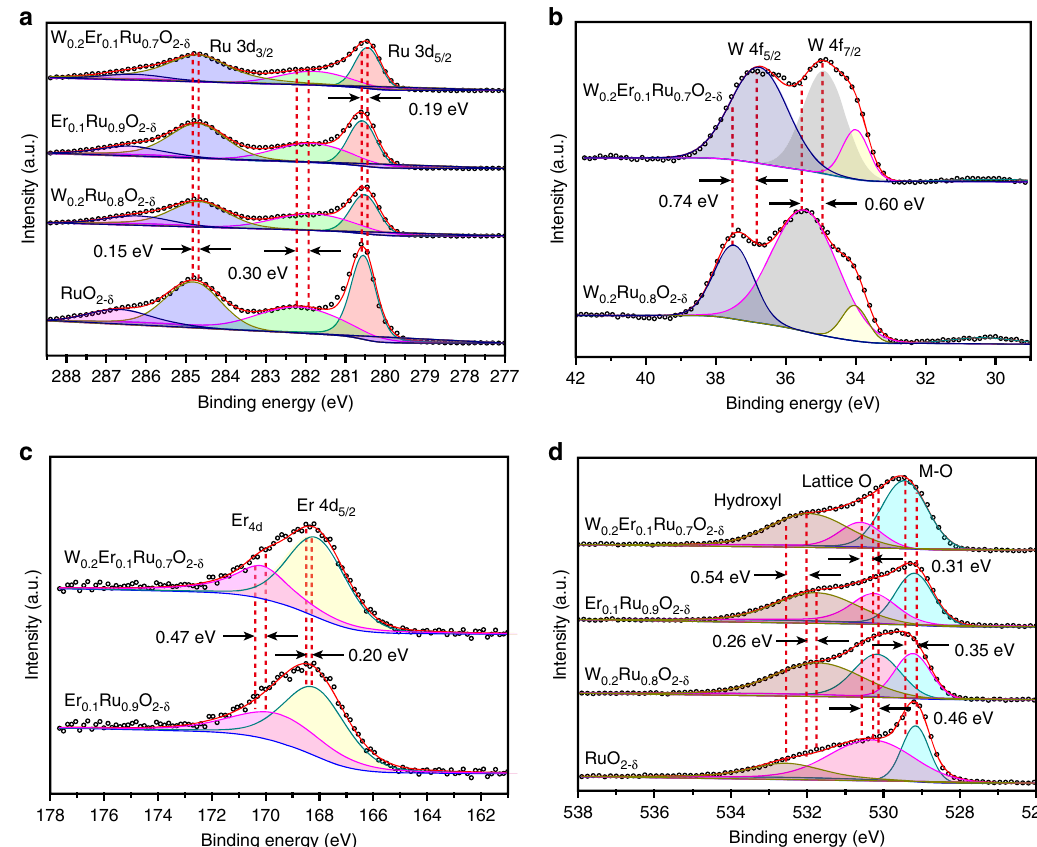
Fig. 4 XPS characterization for W 0.2 Er 0.1 Ru 0.7 O 2 − δ , Er 0.1 Ru 0.9 O 2 − δ , W 0.2 Ru 0.8 O 2 − δ , and RuO 2 − δ nanosheets. a Ru 3 d spectra, b W 4 f spectra, c Er 4 d spectra, d O 1 s spectra for the prepared